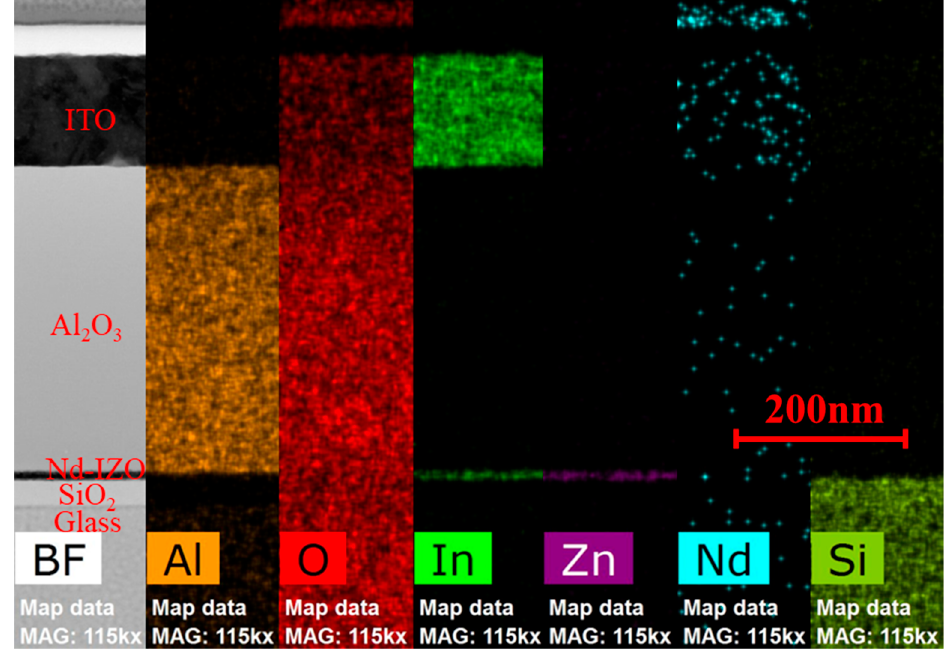
Figure 4. BF STEM image together with the elemental distribution (from left to right: Al, O, In, Zn, Nd, Si) detected by EDS.